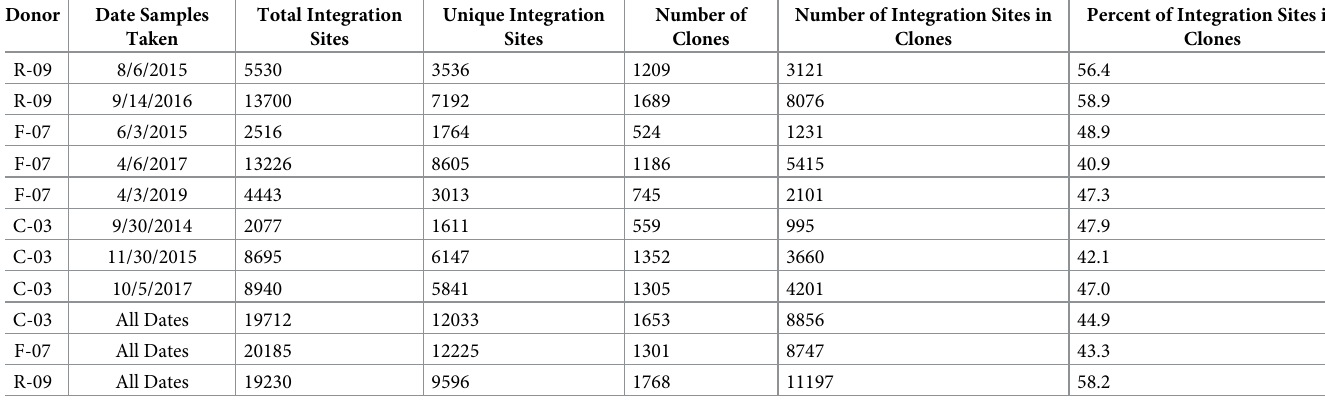
Table 3. Integration Sites Recovered and Numbers of Infected